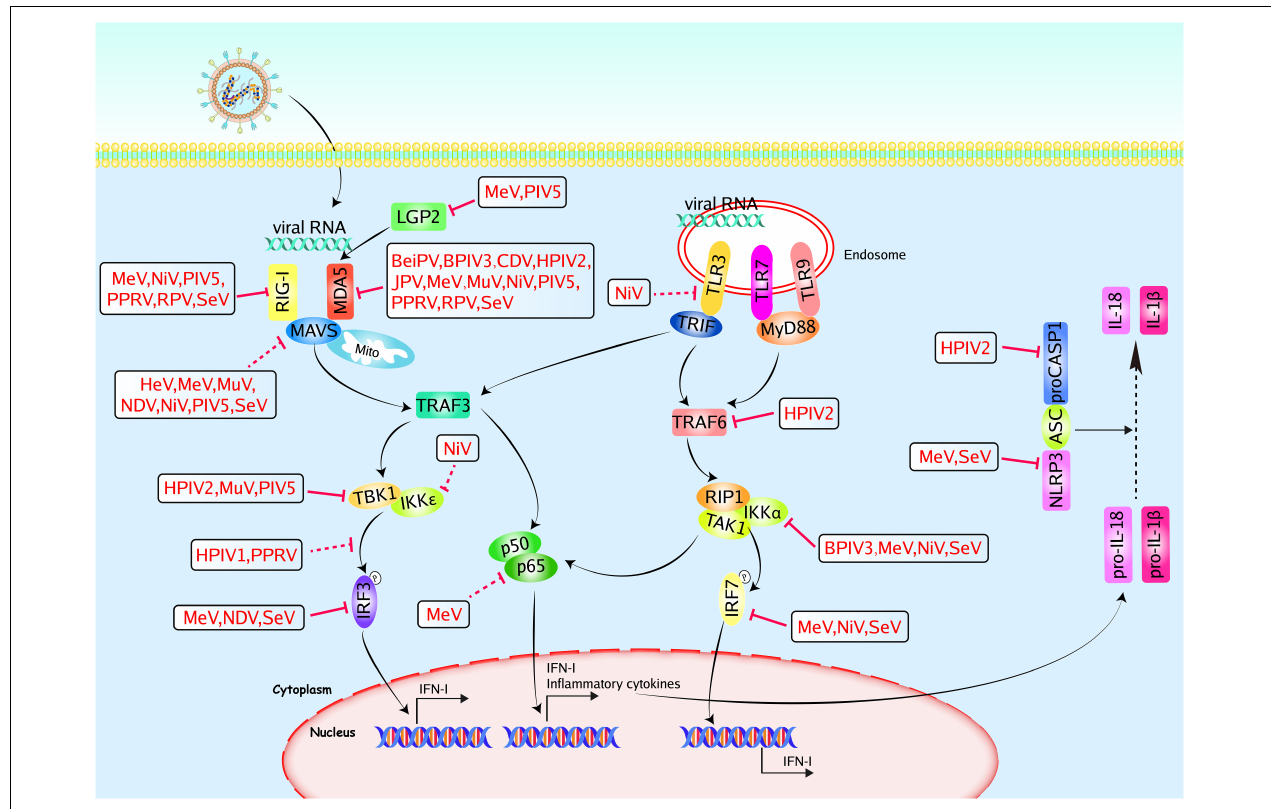
FIGURE 2 | Paramyxoviruses accessory proteins-mediated evasion of the PRR-mediated antiviral innate immunity. PRRs, such as TLRs, and RLRs, could recognize pathogen-associated molecular patterns. TLR3/7/9 locate at endosomes. They sense viral RNA and signal through TRIF or MyD88 to activate IRFs and NF- κ B. RIG-I and MDA5 recognize viral RNA and signal through MAVS to activate IRF3 and NF- κ B. The NLRP3-mediated inflammasome pathway operates as a platform for the maturation of IL-1 β and IL-18. Paramyxoviruses accessory proteins can hijack multiple steps in the PRR-mediated antiviral innate immunity. The V proteins of MeV, NiV, PIV5, PPRV, RPV, and SeV could inhibit RIG-I, and the V proteins of BeiPV, BPIV3, CDV, HPIV2, JPV, MeV, MuV, NiV, PIV5, PPRV, RPV, and SeV could inhibit MDA5. The V proteins of MeV and PIV5 could inhibit LGP2, and the V proteins of HeV, MeV, MuV, NDV, NiV, PIV5, and SeV could inhibit MAVS. The V proteins of HPIV2, MuV, and PIV5 could inhibit TBK1, the V and W proteins of NiV could inhibit IKK ε . The PPRV P protein could inhibit TBK1-IRF3 interaction and the V proteins of MeV, NDV, and SeV could inhibit IRF3. The HPIV1 C protein could prevent the phosphorylation of IRF3. The P, V, and C proteins of MeV could inhibit p65. The NiV W protein could inhibit TLR3 and the HPIV2 V protein could inhibit TRAF6 and caspase1, respectively. The C proteins of BPIV3, MeV, NiV, and SeV could inhibit IKK α , the V proteins of MeV, NiV, and SeV could inhibit IRF7. The V proteins of MeV and SeV could inhibit NLRP3. Red solid lines indicate confirmed interactions between adaptors and accessory proteins, and red dashed lines indicate uncertain interactions or unknown underlying mechanisms; P,